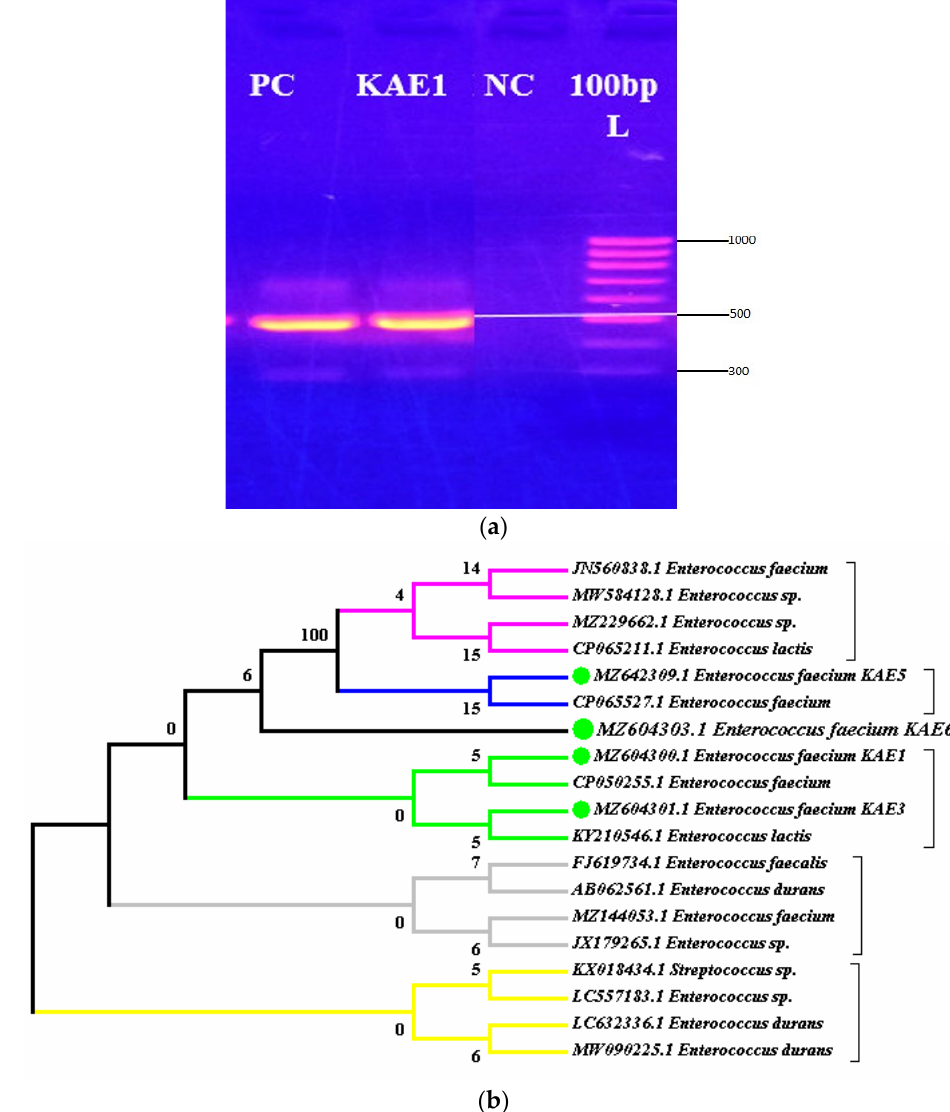
Figure 2. ( a ) Agarose gel electrophoresis showing Positive Control (Lane 1), 16s rDNA fragment amplified by PCR from genomic DNA of strain KAE01, corresponding to 500 bp (Lane 02), Negative Control (Lane 3), and DNA molecular weight marker of 1000 bp (Lane 4). ( b ) Phylogenetic tree constructed based on 16s rDNA sequence amplified from genomic DNA of strain E. faecium KAE01 and other strains obtained from BLAST results.